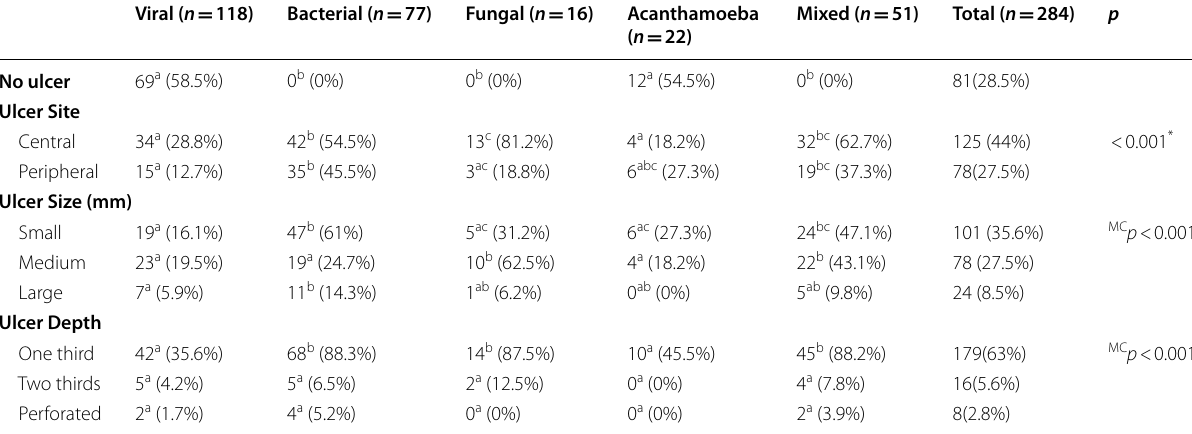
Numbers with different letters are significant MC Monte carlo, p : p -value for comparing between the studied groups * Statistically significant at p ≤